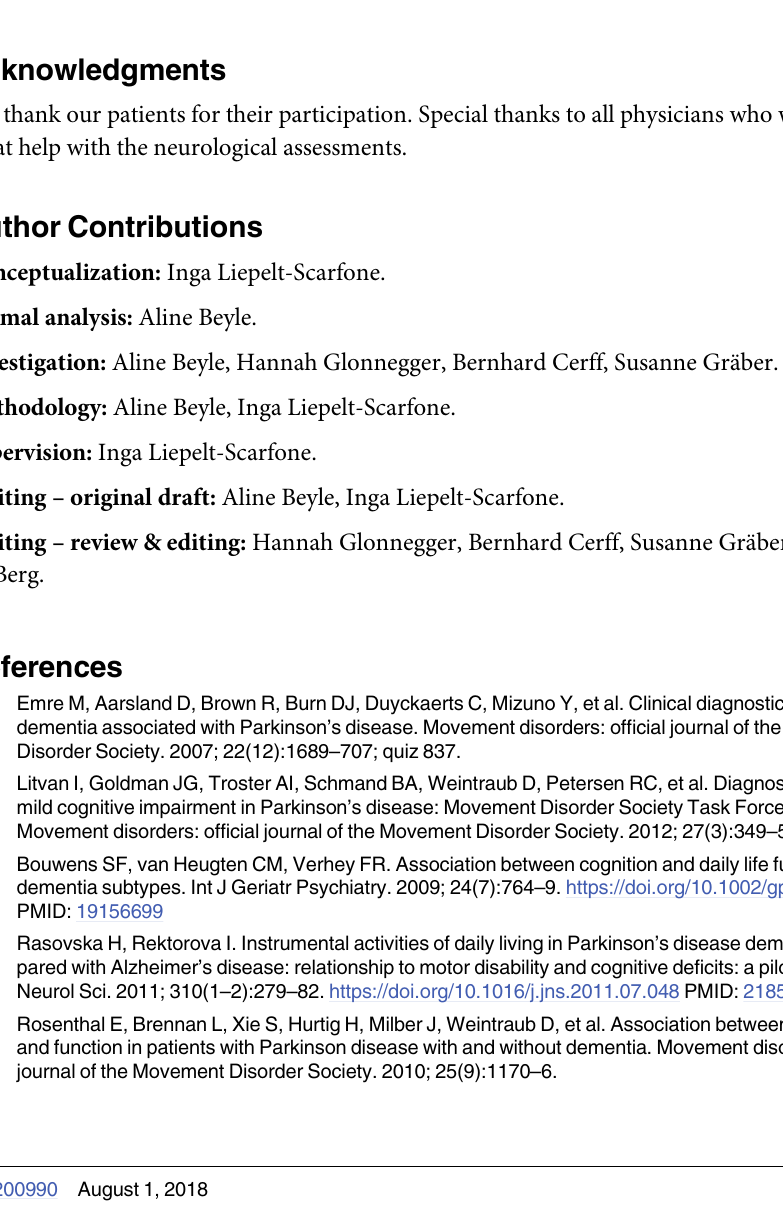
S1 Table. Cognitive profile for each patient group at baseline. Baseline cognitive profile of PD patients with (PD-CI) and without (PD-noCI) cognitive impairment, as well as with mild cognitive impairment (PD-MCI) and dementia (PDD). S2 Table. Baseline characteristics including the lost to follow-up cohort. Baseline character- istics of all 131 Parkinson’s disease patients and between group comparison of follow-up (n = 73) and lost to follow-up (n = 58) cohort. S3 Table. Correlation analysis between MOT change scores and change scores of clinical parameters. Correlation between change scores of MOT parameters change scores of the UPDRS-III and neuropsychological data using theSpearman-rank correlation coefficient